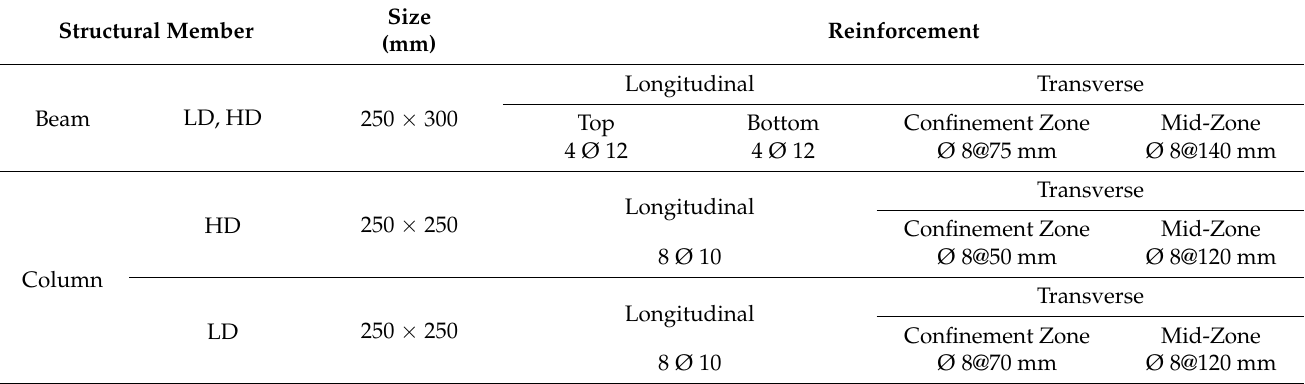
Figure 3. Reinforcement and steel section details of the frames in LS-DYNA: ( a ) HD; ( b ) LD.